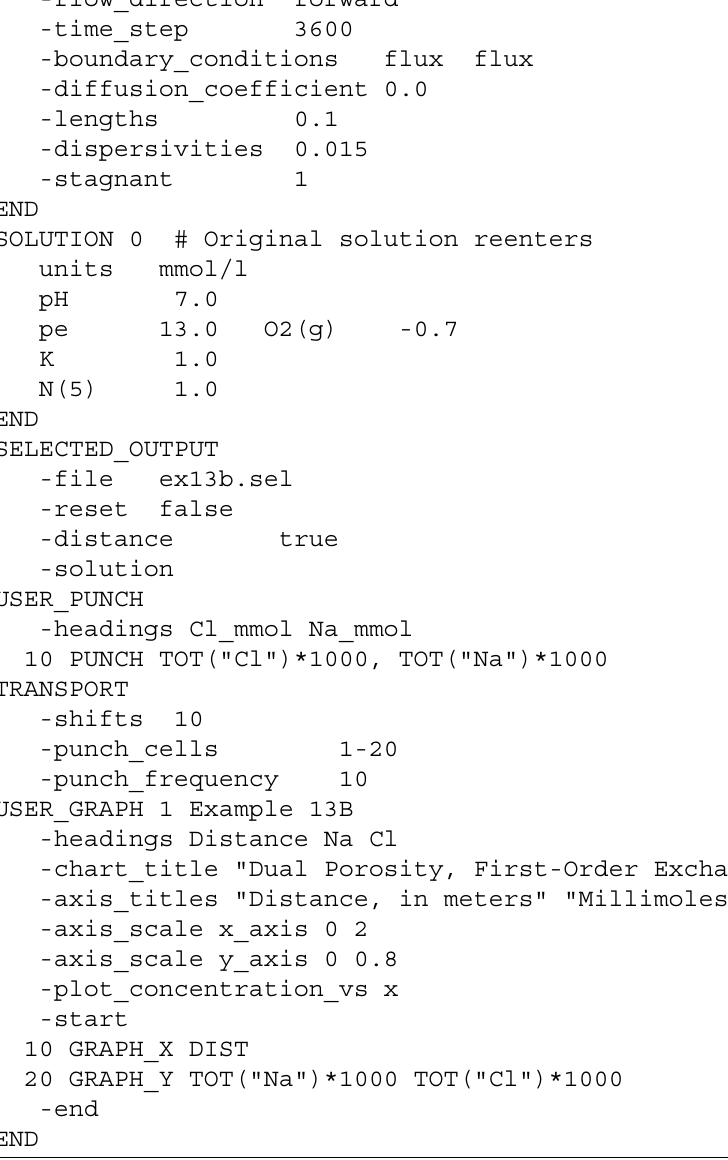
Table 34. Input file for example 13B: Stagnant zone with explicitly defined mixing